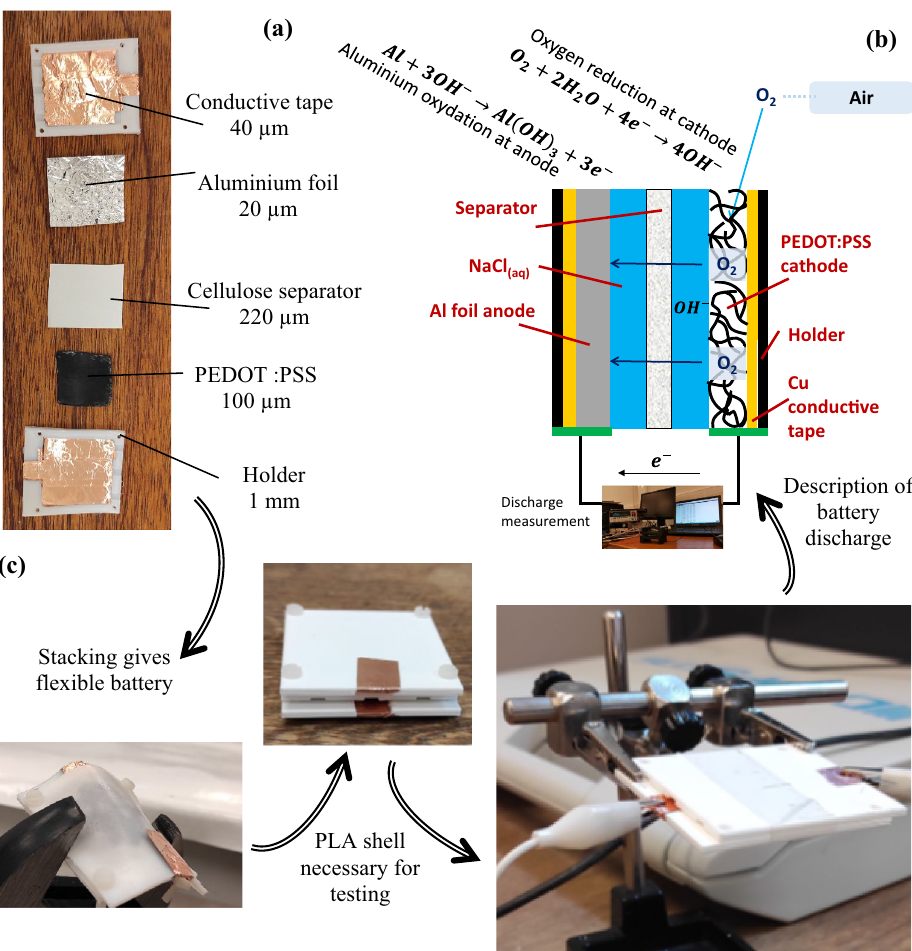
Figure 6. ( a ) Battery components, ( b ) schematic representation of the battery functioning and the chemical reactions during battery discharge, ( c ) assembled flexible battery and discharge